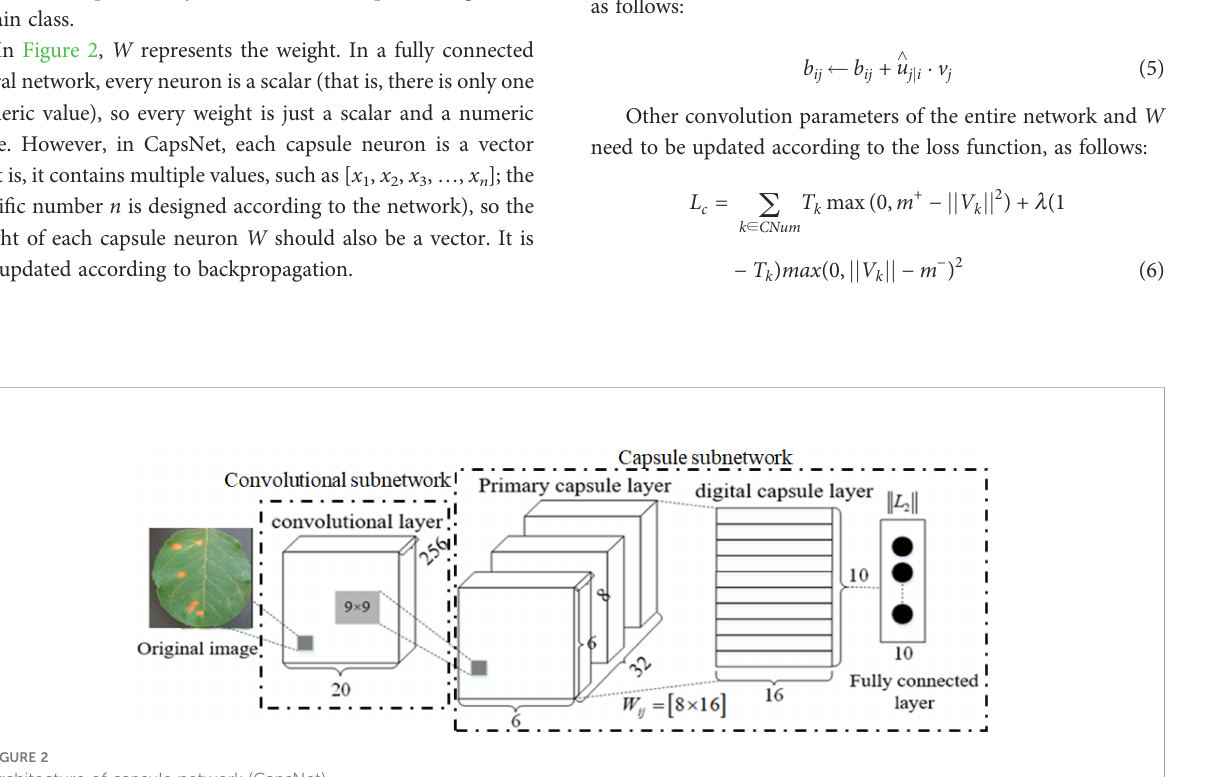
FIGURE 2 Architecture of capsule network